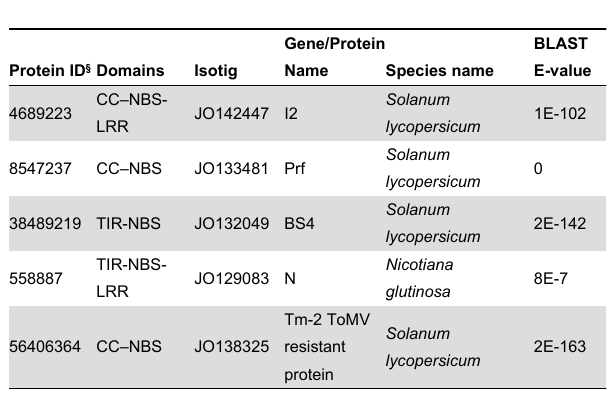
Table 4. Resistance genes reported in model organisms with significant hits in the Cape gooseberry transcriptome.